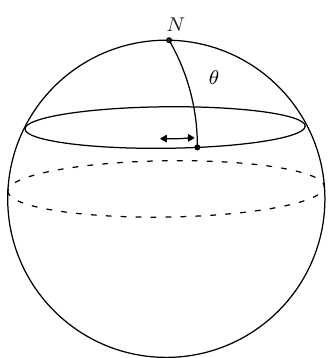
SO(3) / SO(2), i.e., the angle between north pole and different \